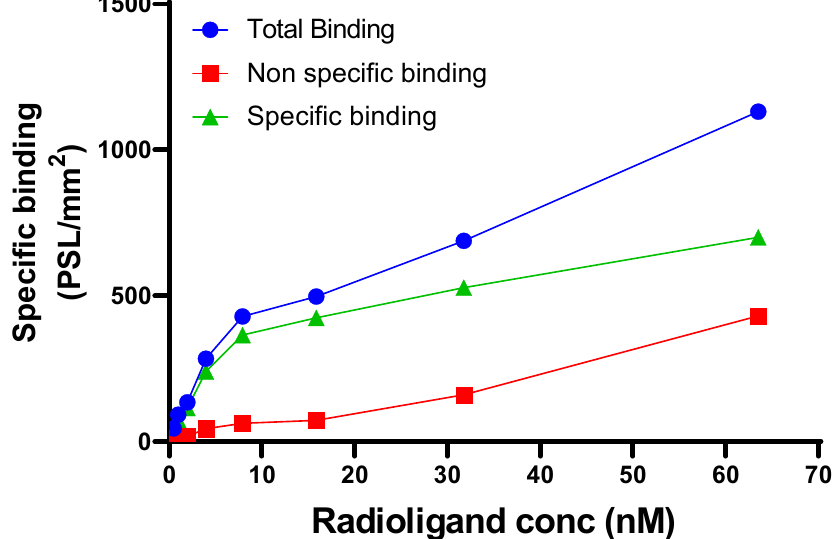
Table 1. Stability of [ 11 C]MPC-6827 in human serum sample ex vivo .